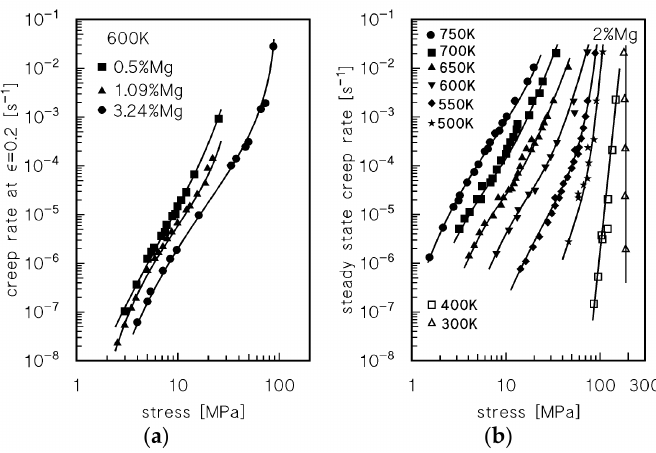
Figure 4. Literature data on the creep of Al-Mg alloys: strain rate at 0.2 strain data from [4] ( a ) and steady-state creep and steady-state flow stress from constant strain rate experiments from [16] ( b ).